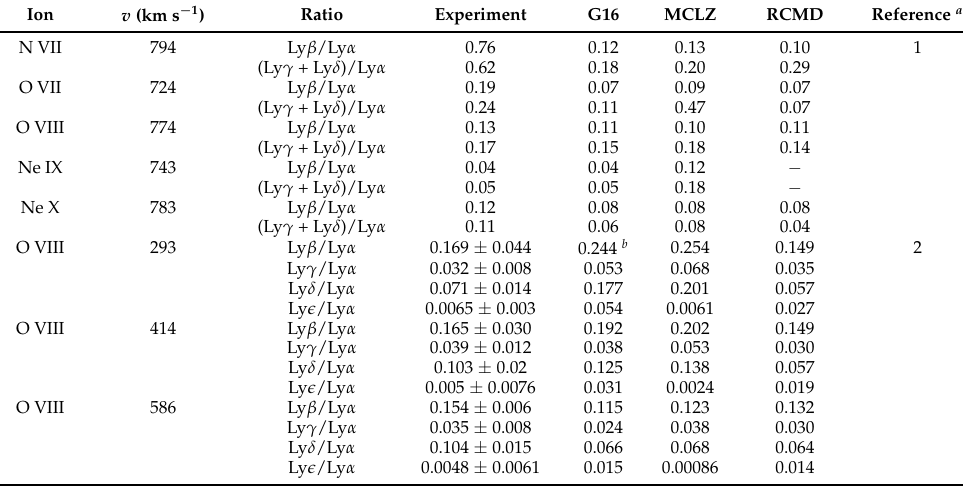
Table 2. Experimental and theoretical Line